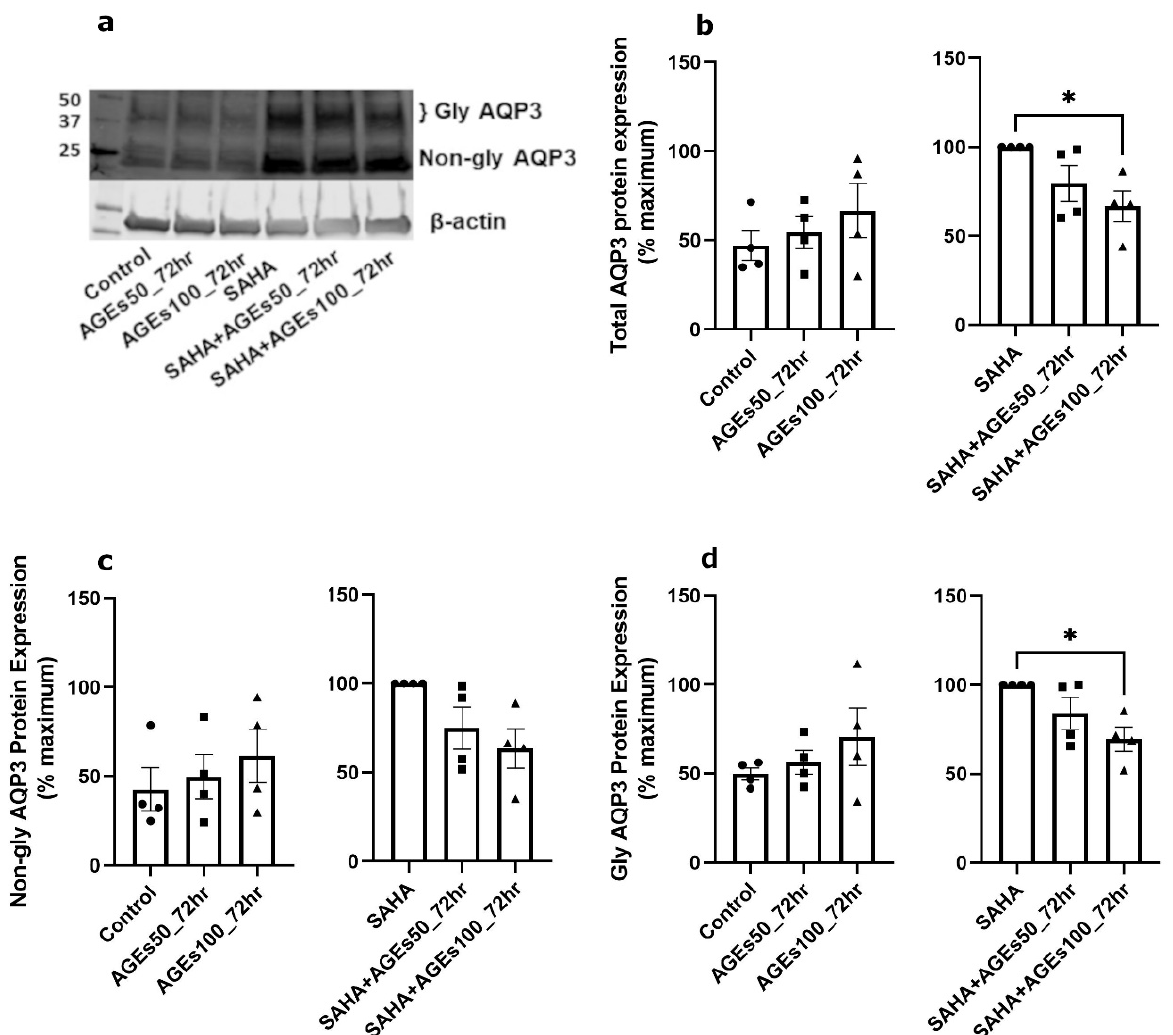
Figure 7. A 72-h Treatment with BioVision AGEs Altered Keratinocyte AQP3 Protein Levels. Western blotting of mouse keratinocytes treated for 72 h with 50 or 100 µ g/mL AGEs. ( a ) Representative Western blot showing AQP3 protein expression. ( b ) Left panel: total AQP3 protein expression in the absence of SAHA. Right panel: total AQP3 protein expression in the presence of SAHA. ( c ) Left panel: non-glycosylated AQP3 protein expression in the absence of SAHA. Right panel: non-glycosylated AQP3 protein expression in the presence of SAHA. ( d ) Left panel: glycosylated AQP3 protein expression in the absence of SAHA. Right panel: glycosylated AQP3 protein expression in the presence of SAHA. The data are analyzed as in Figure 3 and expressed as % maximal response; values represent the means ± SEM from four independent experiments, with symbols representing individual experiments. * p < 0.05 versus the control value.